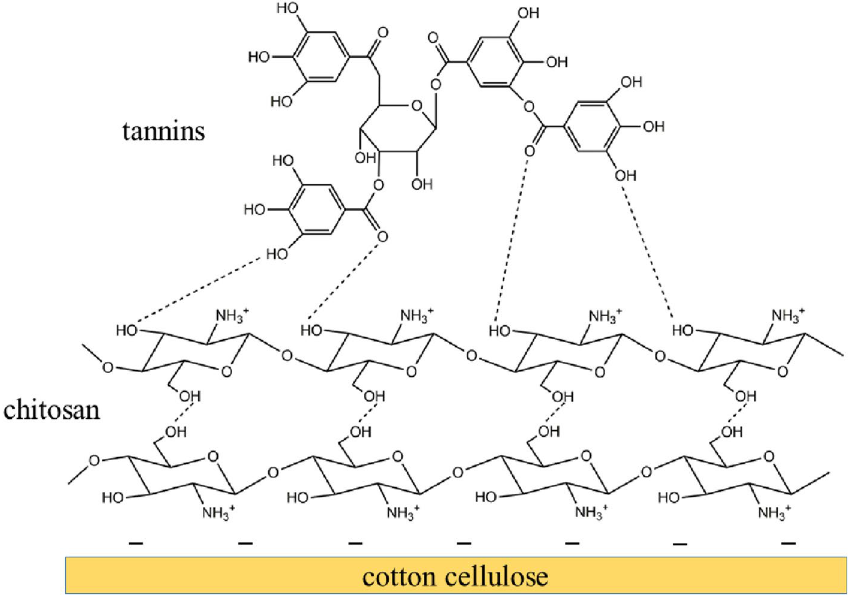
Fig. 4 Schematic representation of cotton fabric dyed with Aronia berries extract after chitosan